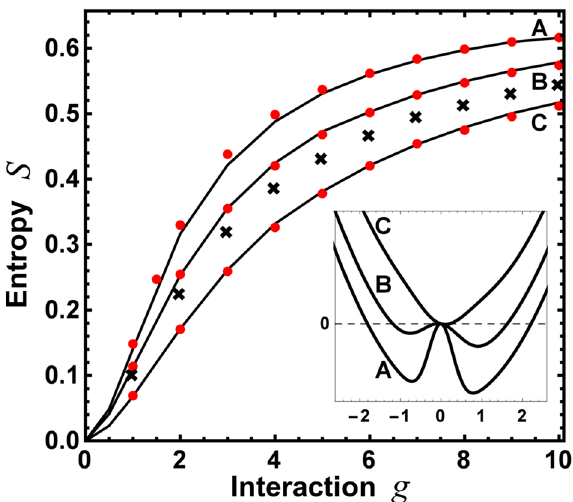
2 bosons encoded in the single- Figure 2. Entanglement entropy S calculated for the system with N = particle density matrix ρ( x , x ′ ) as a function of interactions and for three different shapes of the confinement: 0.5, 0.5, 0.3 ) respectively for trap A, B, and C shown in inset. ( (cid:31) , δ , ξ) ( 2.0, 0.3, 0.2 ) , (1.0, 0.5, 0.2), and ( = − Exactly as in Fig. 1, predictions of the ansatz (red points) are consistent with numerically exact results (solid x y , is unreliable for strong lines). Contrary, the naive ansatz (black crosses), based on substitution D β ( x , y ) = − enough repulsions. For clarity of the Figure we present results from the naive ansatz only for the asymmetric double-well potential labelled by B. For other confinements the results are